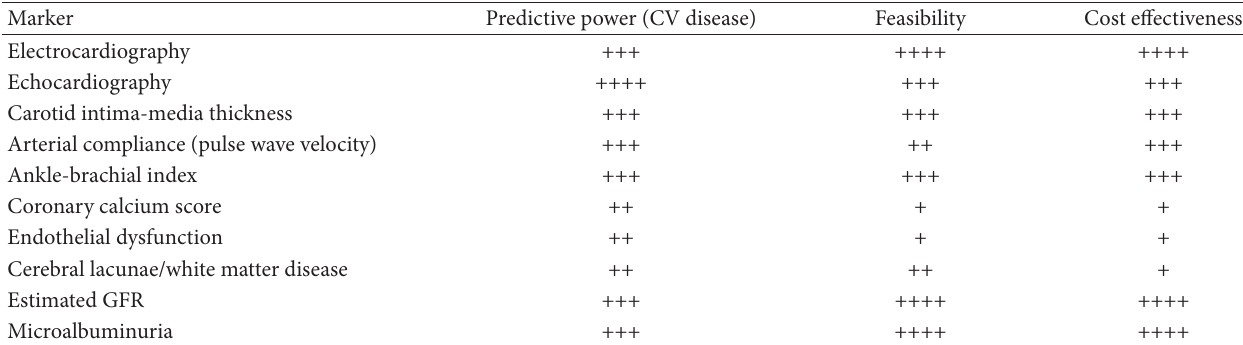
Table 1: ESH-ESC Guidelines